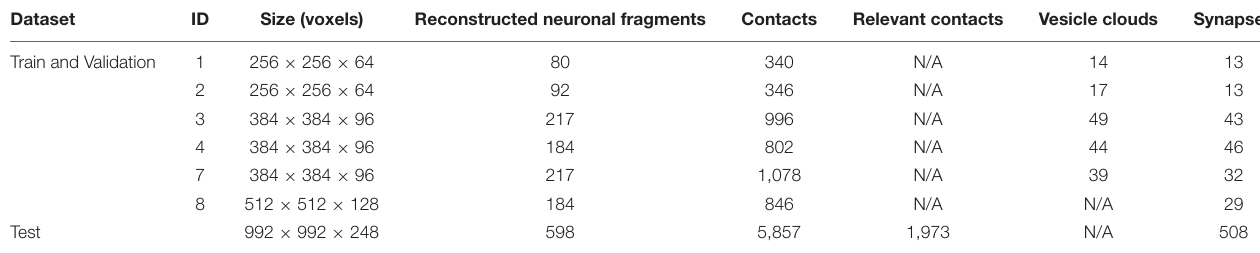
TABLE 2 | The basic statistics of the datasets.